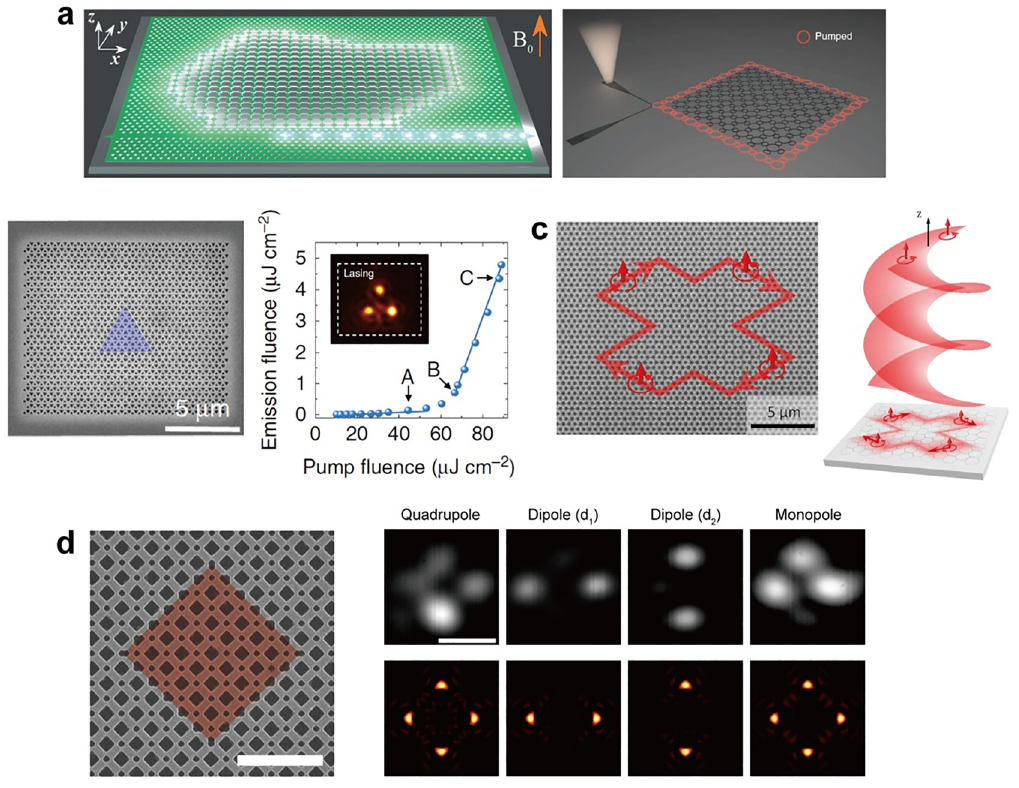
Figure 4: Representative topological lasers. (a) Left, one-way topological edge-state laser by applying static magnetic field B 0 to the cavity (adopted from Ref. [42]). Right, topological edge-state laser without an external magnetic fi eld (adopted from Ref. [43]). (b) Lasing from a 2D valley-Hall topological cavity. SEM image of thefabricatedtopologicalcavity(left)andmeasurement ofemissionenergyversusthepumpenergy(right).The insetof therightpanelshows the spatial distribution of the above-threshold emission (adopted from Ref. [44]). (c) Topological vortex laser from spin-momentum-locked edge mode. The corresponding spin direction of the cavity mode is indicated by the out-of-plane arrows (adopted from Ref. [45]). (d) Topological corner-state laser. Left, SEM image of the fabricated topological cavity. Scale bar, 2 μ m. Right, measured (top) and calculated (bottom) lasing images of the quadrupole, dipole ( d 1 ), dipole ( d 2 ), and monopole topological modes (from left to right). Scale bar, 10 μ m (adopted from Ref.